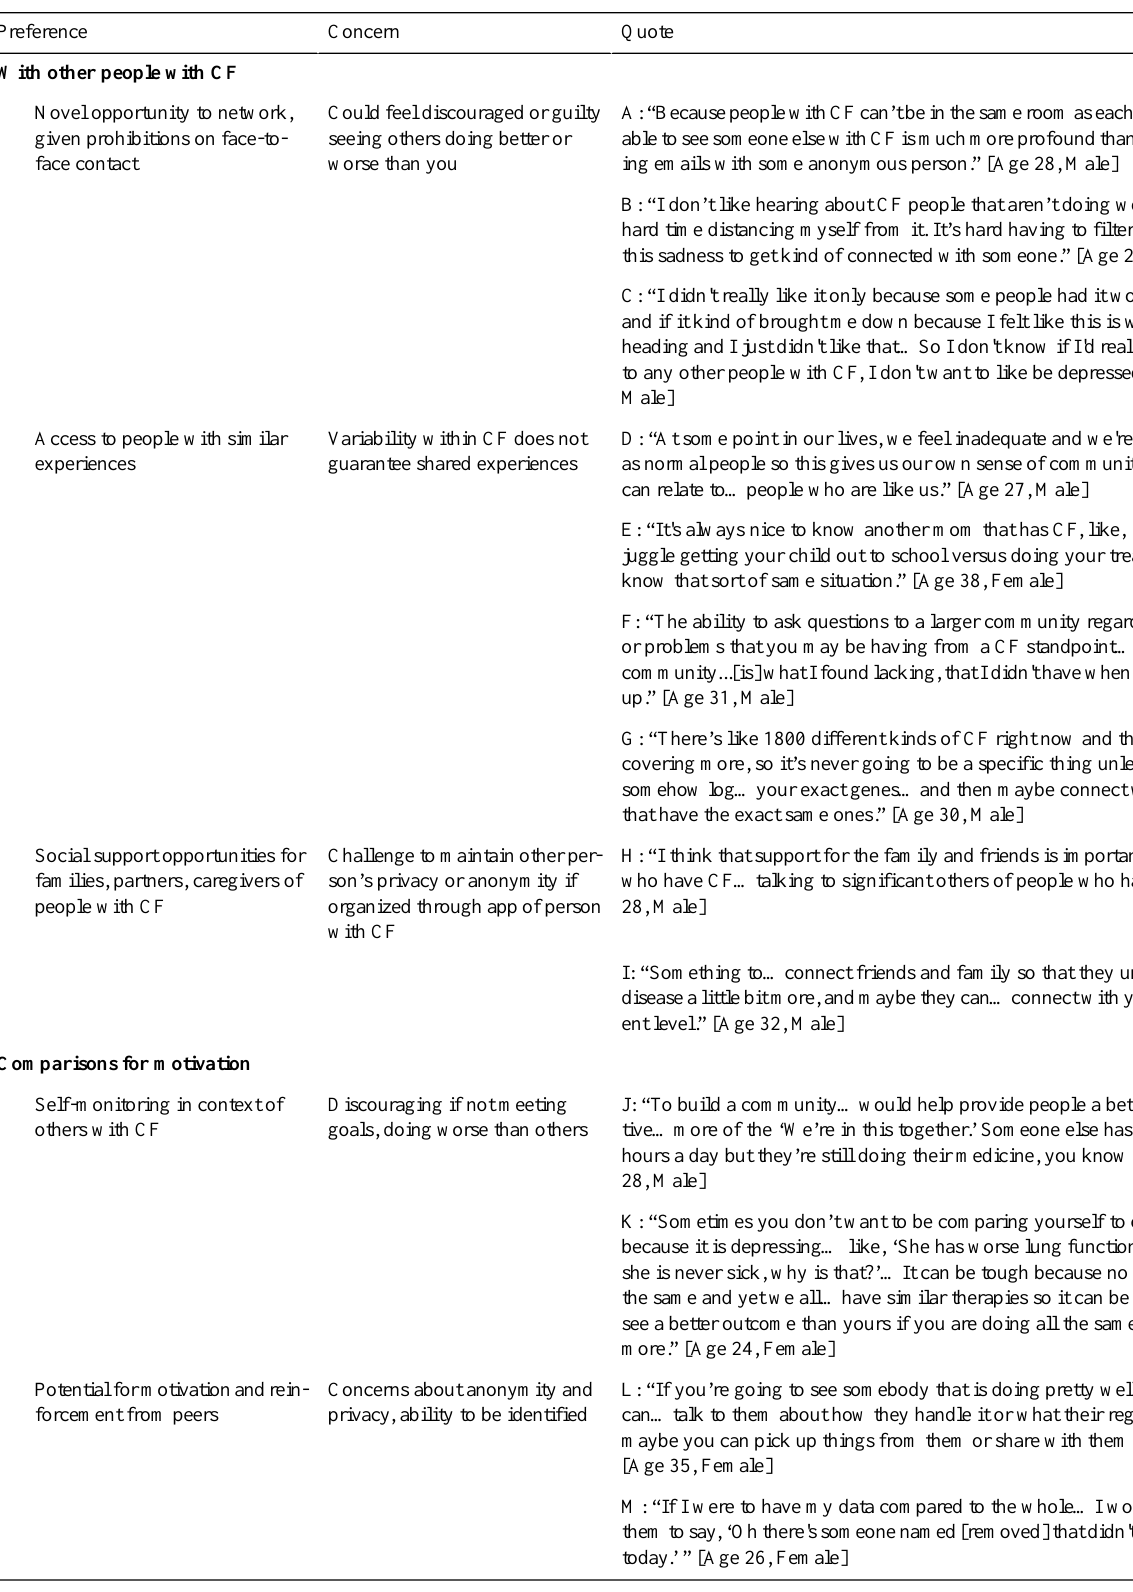
Table 5. Participant preferences, concerns, and illustrative quotes regarding Socialization